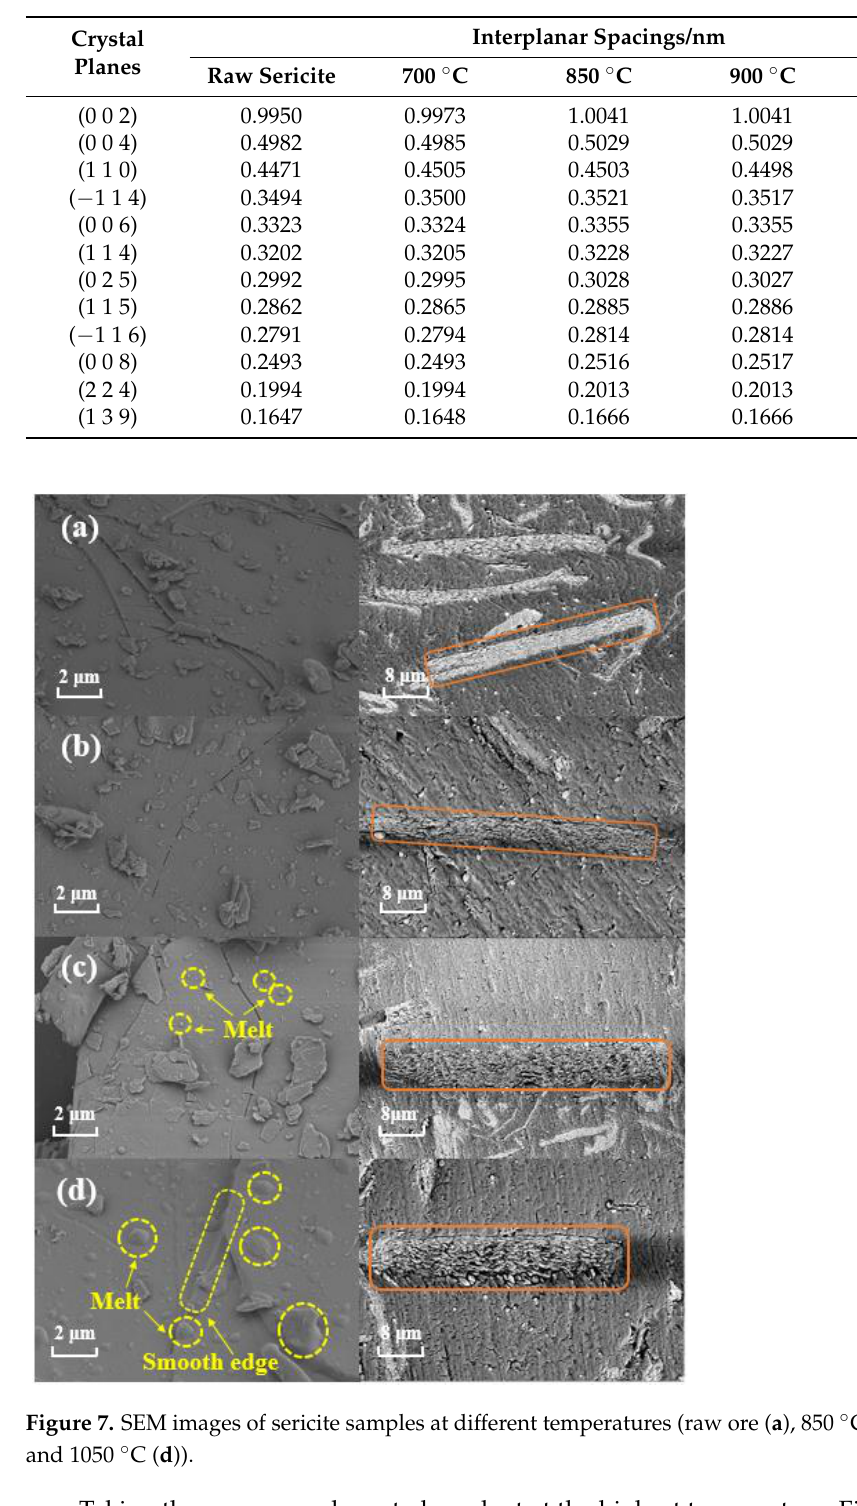
Table 2. The interplanar spacings of diffraction peaks of roasted products.